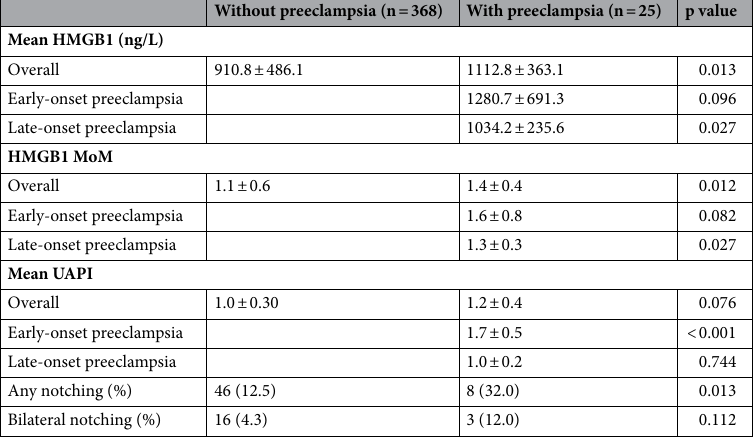
Table 3. Serum HMGB1 levels and uterine artery Doppler findings in women with and without preeclampsia. Data are presented as the mean ± SD, or N (%). HMGB1 High Mobility Group Box-1, UAPI uterine artery pulsatility index, MoM multiple of